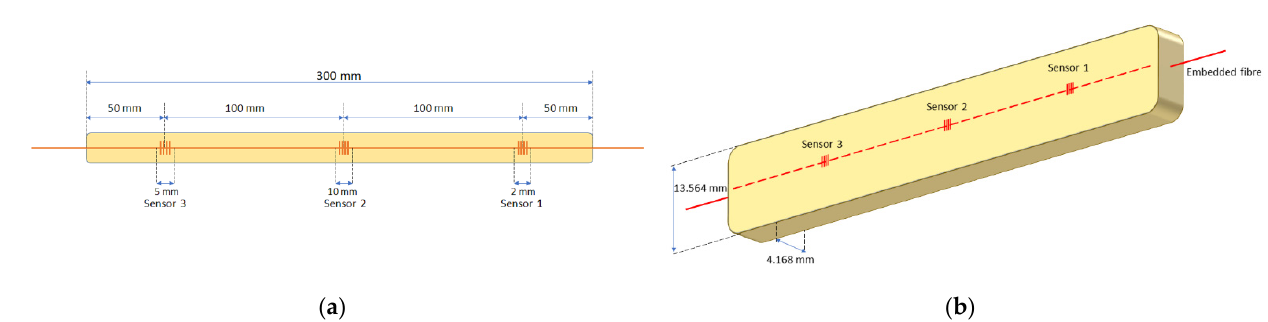
Figure 4. FBG sensor configuration: ( a ) ubication scheme and naming of sensors; ( b ) scheme of beam fabrication, with embedded optical fibre inside.